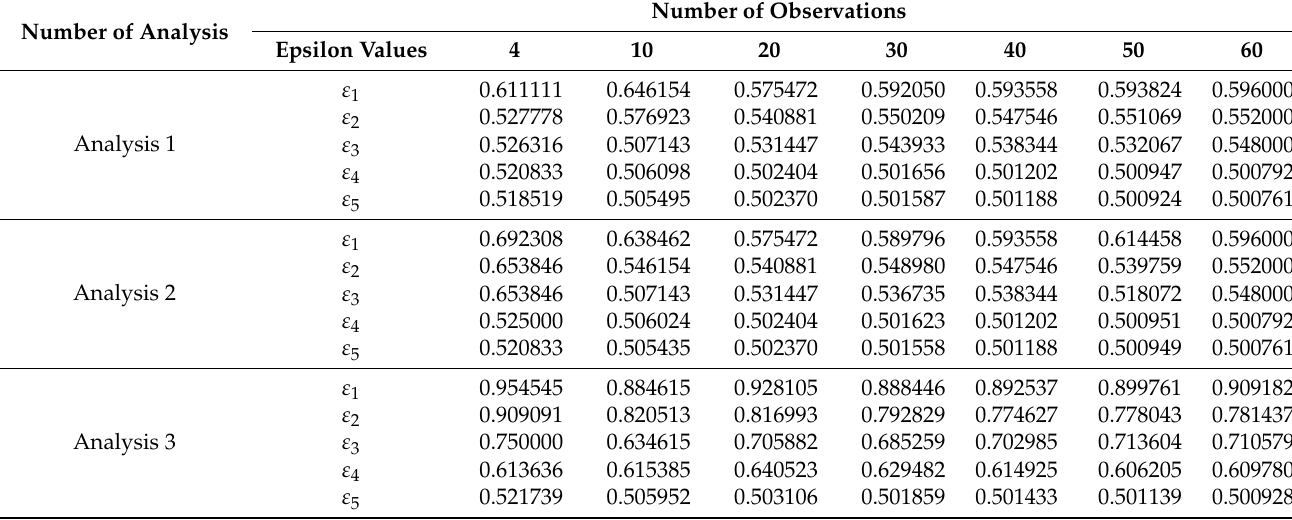
Table 1. ε similarity coefficient values depending on the number of observations included in the